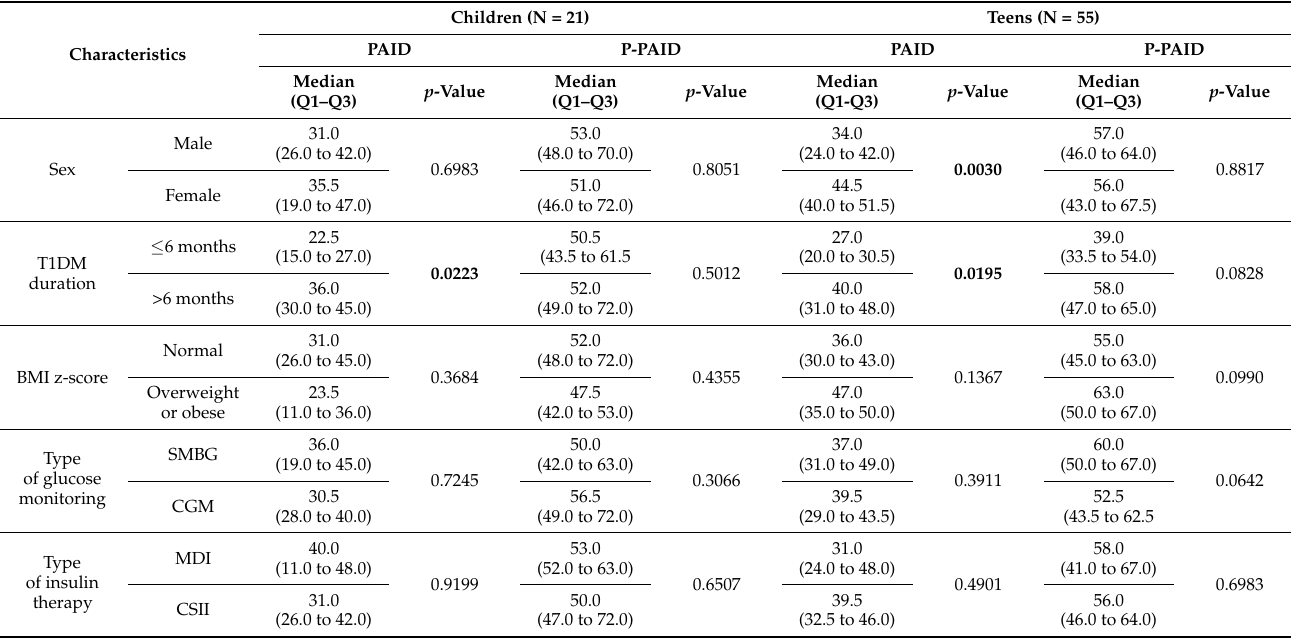
Table A2. Comparison of PAID scores (median (Q1, Q3)) at baseline (1st PAID, i.e., before pandemic) in respect to different clinical characteristics (non-continuous/discrete variables). Significant p -values (<0.05) were bolded.